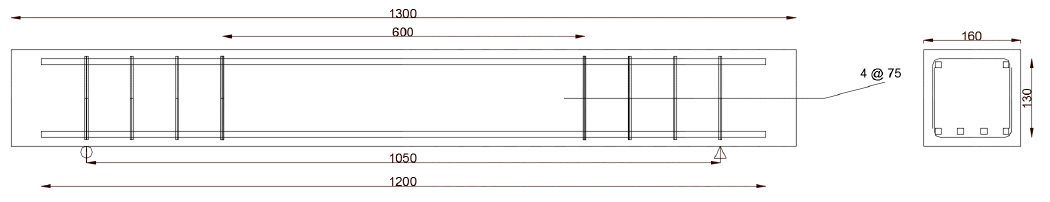
Figure 14. Design of beam D.